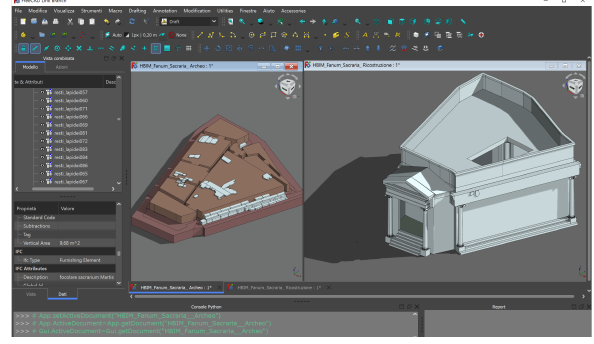
Figure 7 . Parametric models of the Domus Regia . Archaeological situation (left); hypothetical reconstruction (right).